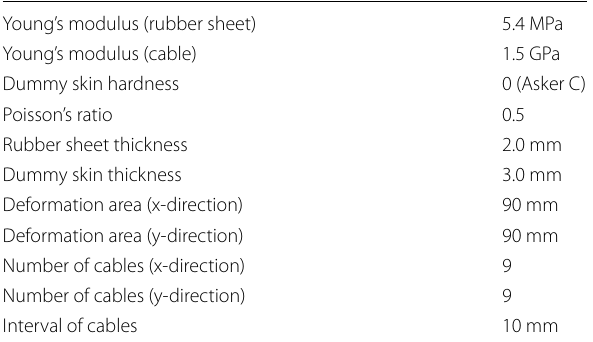
Table 1 Conditions of the shape reproduction parameter